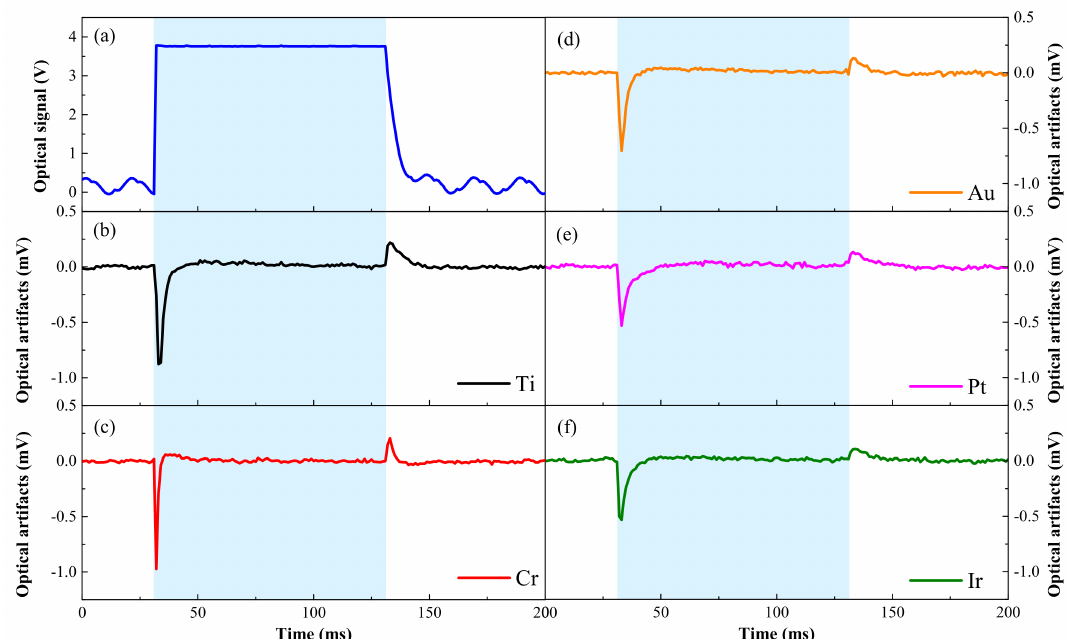
Figure 7. ( a ) The optical signal used in the testing system and the recorded optical artifacts of optrodes made by different surface materials, including ( b ) Ti, ( c ) Cr, ( d ) Au, ( e ) Pt, ( f )